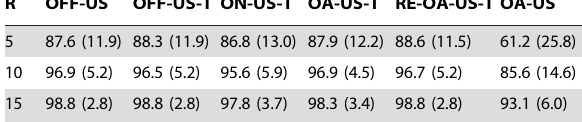
Table 2. Akimpech Spelling